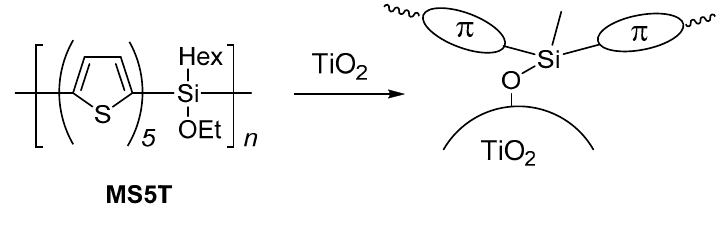
Table 1. Polymer absorption maximum and DSSC performance.